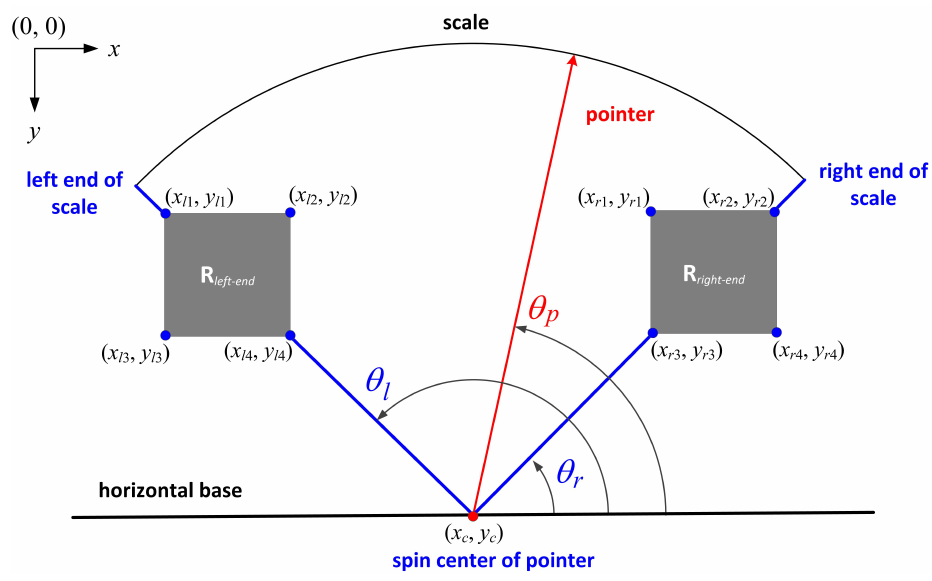
Figure 9. Relationship between the pointer indicated by θ p and scale in the R IM of the A-meter by adding the coordinates of R right-end and those of R left-end , where the scale is confined within the range from θ r to θ l . Note here that the straight line of the right-end of scale passes approximately over ( x ) and ( x ) ∈ R r 2 , y r 2 r 3 , y r 3 right-end and that of left end of scale passes approximately over ( x ) ∈ R left-end , which helps with the calculation of the spin center of pointer l 4 , y l 4 (0, 0) is the top-left coordinate of the